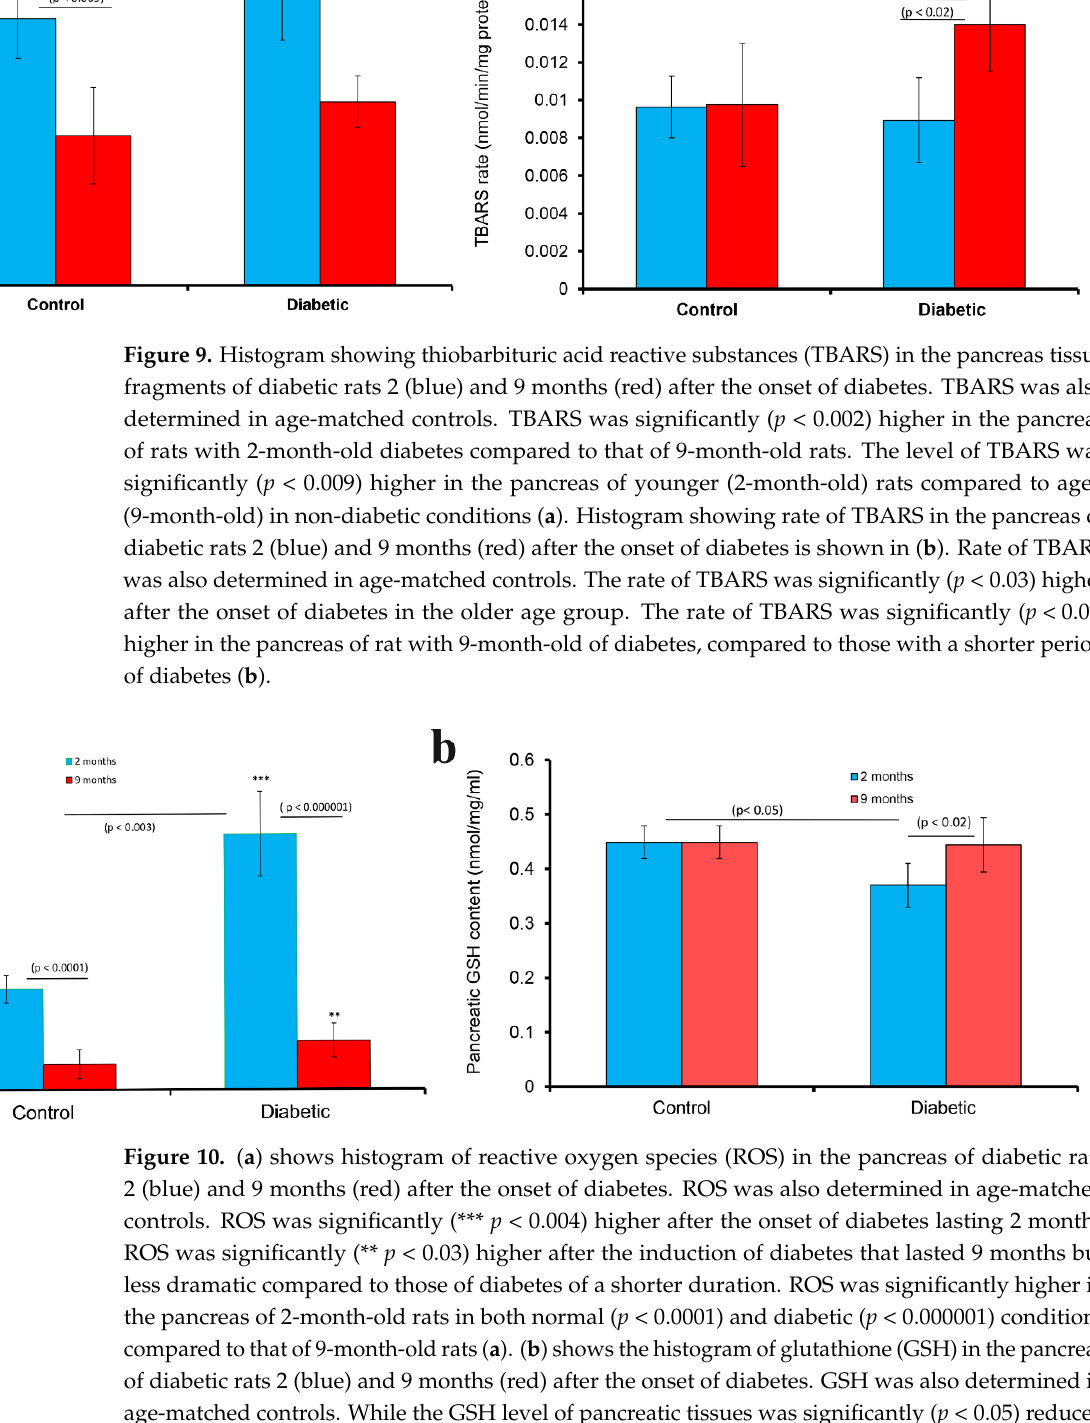
Figure 9. Histogram showing thiobarbituric acid reactive substances (TBARS) in the pancreas tissue fragments of diabetic rats 2 (blue) and 9 months (red) after the onset of diabetes. TBARS was also determined in age-matched controls. TBARS was significantly ( p < 0.002) higher in the pancreas of rats with 2-month-old diabetes compared to that of 9-month-old rats. The level of TBARS was sig- nificantly ( p < 0.009) higher in the pancreas of younger (2-month-old) rats compared to aged (9- month-old) in non-diabetic conditions ( a ). Histogram showing rate of TBARS in the pancreas of diabetic rats 2 (blue) and 9 months (red) after the onset of diabetes is shown in ( b ). Rate of TBARS was also determined in age-matched controls. The rate of TBARS was significantly ( p < 0.03) higher after the onset of diabetes in the older age group. The rate of TBARS was significantly ( p < 0.02) higher in the pancreas of rat with 9-month-old of diabetes, compared to those with a shorter period of diabetes ( b ).